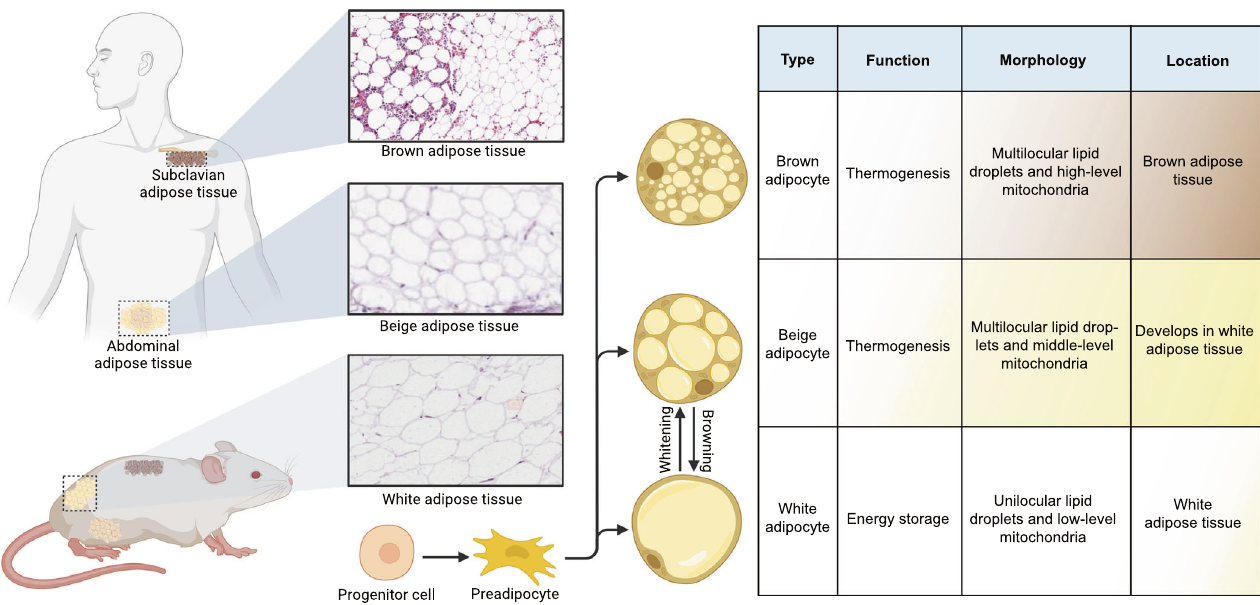
Fig. 1 The biogenesis of different adipocytes and their characteristics. The three mature adipocytes including white adipocytes, beige adipocytes, and brown adipocytes can derive from progenitors via de novo differentiation. Importantly, white adipocytes can reinstall the thermogenic program by mitochondria biogenesis in response to cold and certain other stimuli. When external stimuli are withdrawn, mitochondria-enriched beige adipocytes transform into dormant adipocytes that resemble white adipocytes. In addition, the three types of adipocytes have distinct morphology and anatomical location. White adipocytes are mostly distributed in white adipose tissue, existing in various subcutaneous and intra-abdominal depots and contributing to the storage and release of energy. Stimulated by beigeing factors, beige adipocytes appear in white adipose tissue sporadically. Compared with beige adipocytes, brown adipocytes are an embryonic-origin cell type and cluster in designated depots like interscapular brown adipose tissue depots of mice and infants. However, both brown and beige fat cells are capable of thermogenesis because they have multilocular lipid droplets and densely packed mitochondria. Part of the HE images in this fi gure is generated from the Human Protein Atlas. This fi gure was created on BioRender.com with permission for